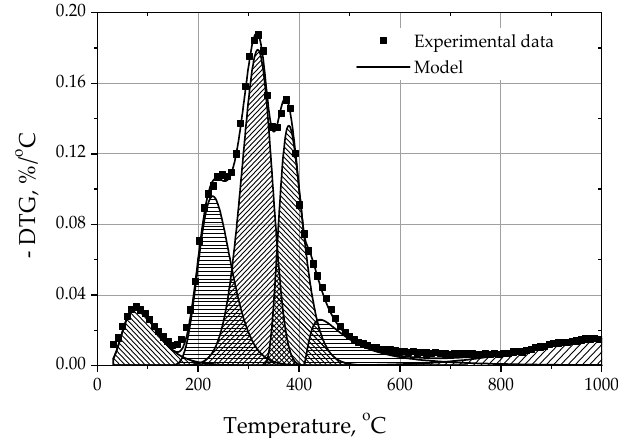
Figure 3. Peak deconvolution of the DTG curve at 10 °C/min. Table 3. Deconvolution peak characteristics.